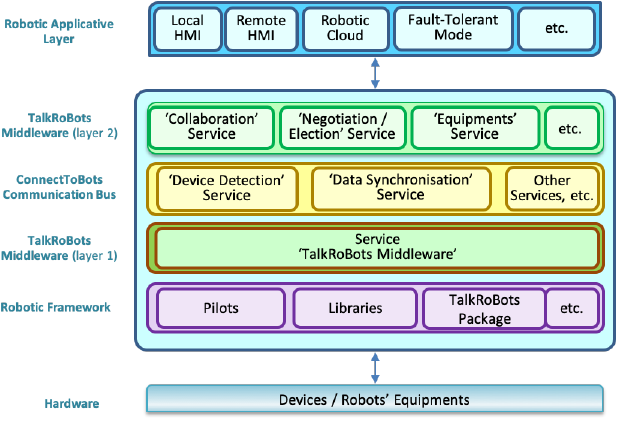
Figure 1. TalkRoBots